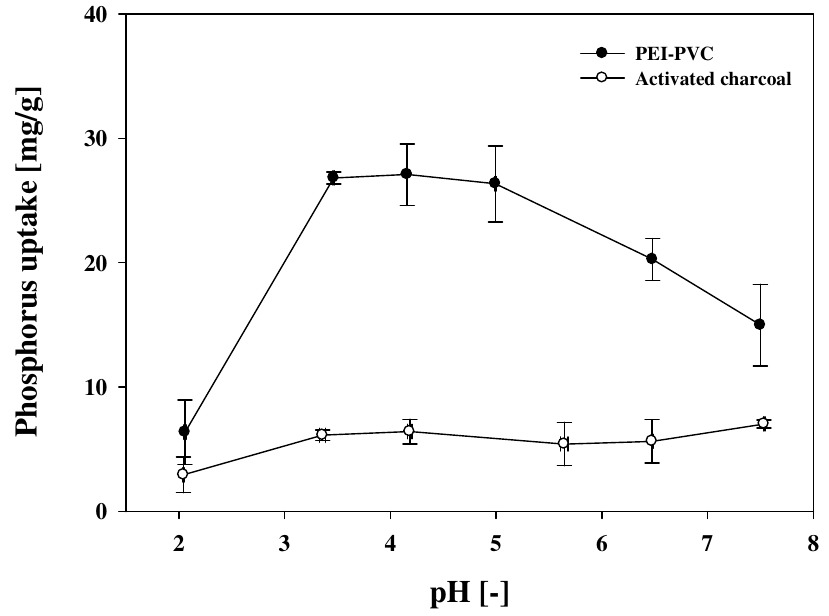
Figure 4. pH effect on the phosphorus sorption uptake of PEI-PVC and activated charcoal.